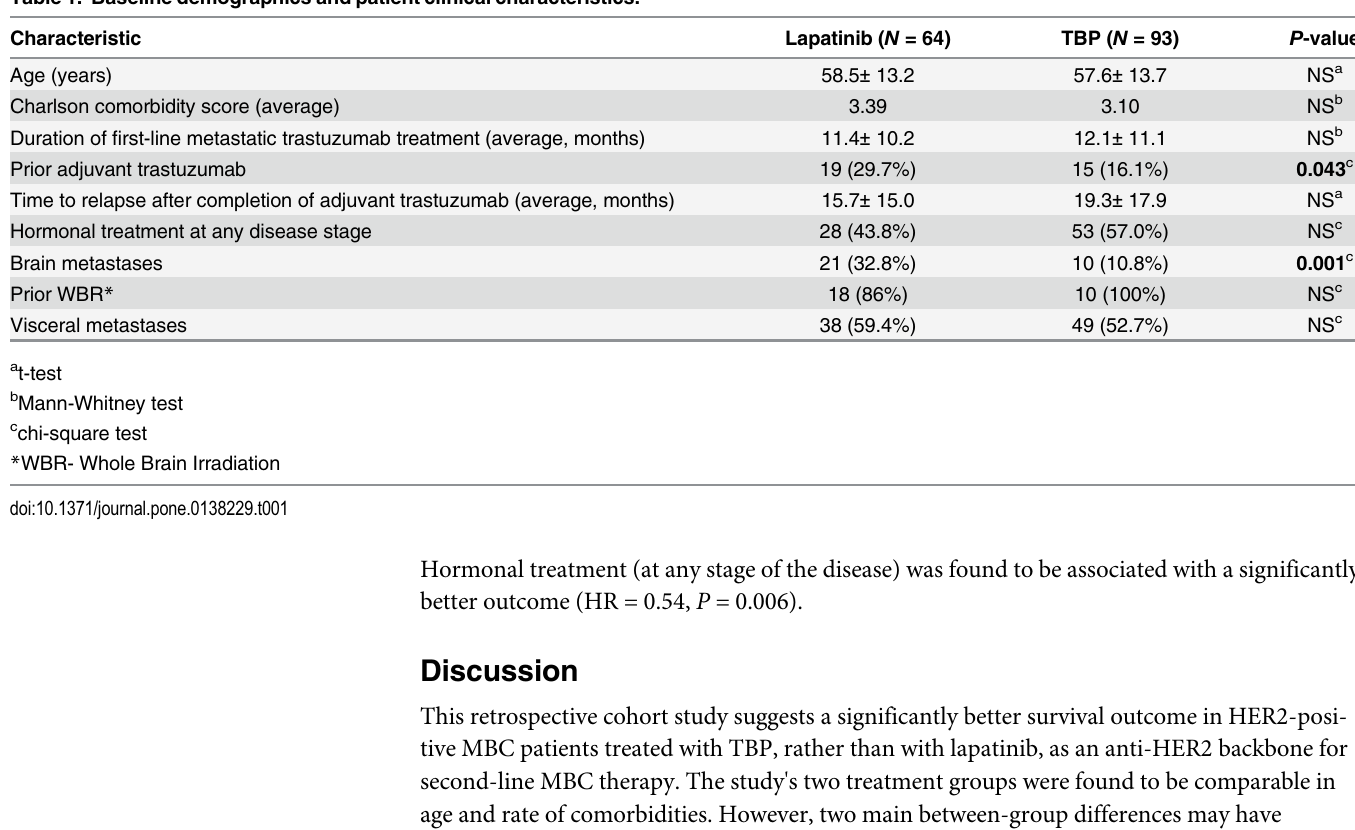
Table 1. Baseline demographics and patient clinical characteristics.